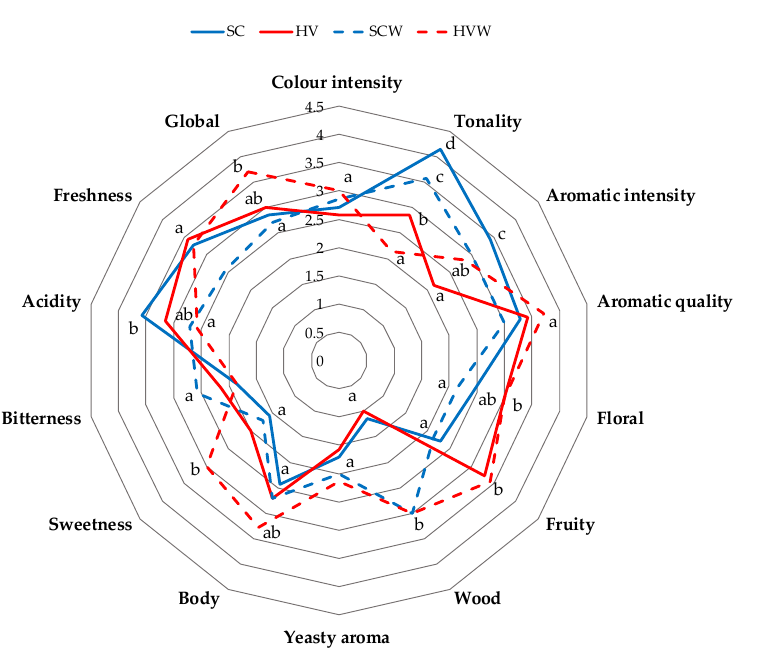
Figure 5. Spider plot showing sensory analysis by eight trained tasters. SC (fermentations with S. cerevisiae in stainless steel barrels); HV (fermentations with H. vineae in stainless steel barrels); SCW (fermentations with S. cerevisiae in oak barrels); HVW (fermentations with H. vineae in oak barrels). Means in the same axis with the same letter are not significantly different ( p < 0.05).